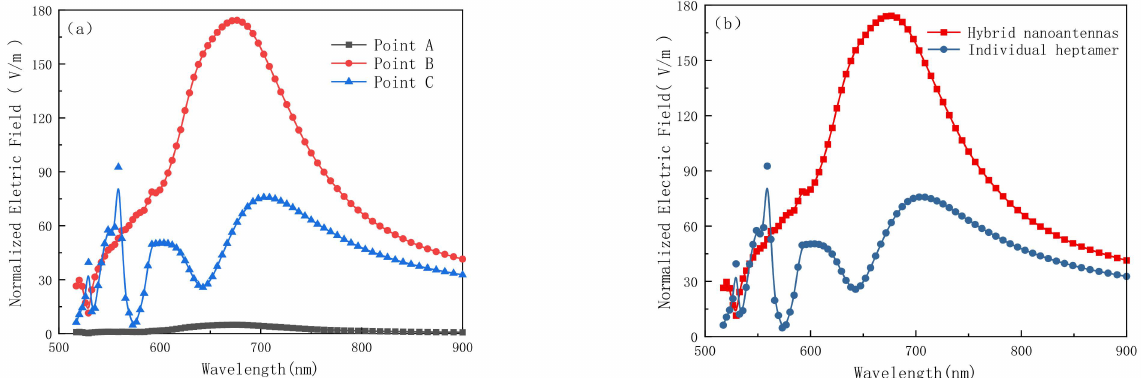
Figure 6. ( a ) Normalized electric fields of the hybrid nanoantennas at points A, B and C; ( b ) Comparison of the normalized electric fields of the hybrid nanoantennas with individual hepatmers at point B.